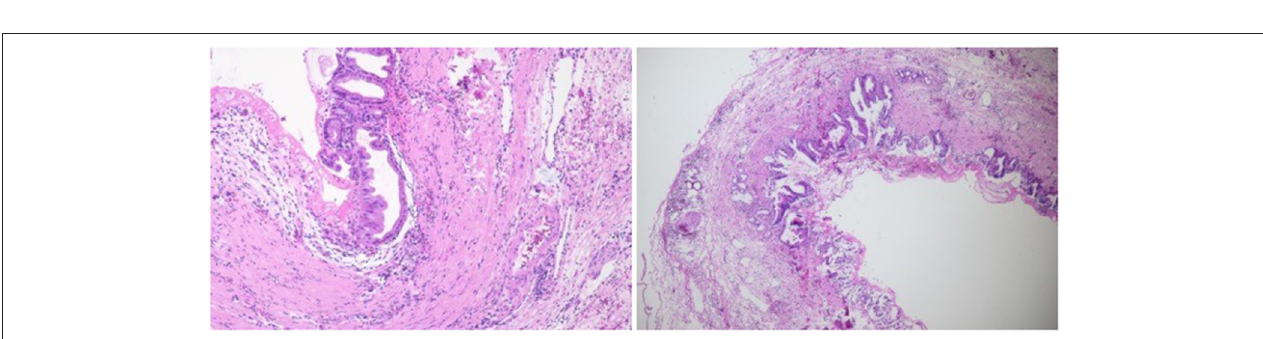
FIGURE 3 | Postoperative pathological images (H&E staining). Under the microscope, a flat bile duct epithelium could be observed ( × 100).